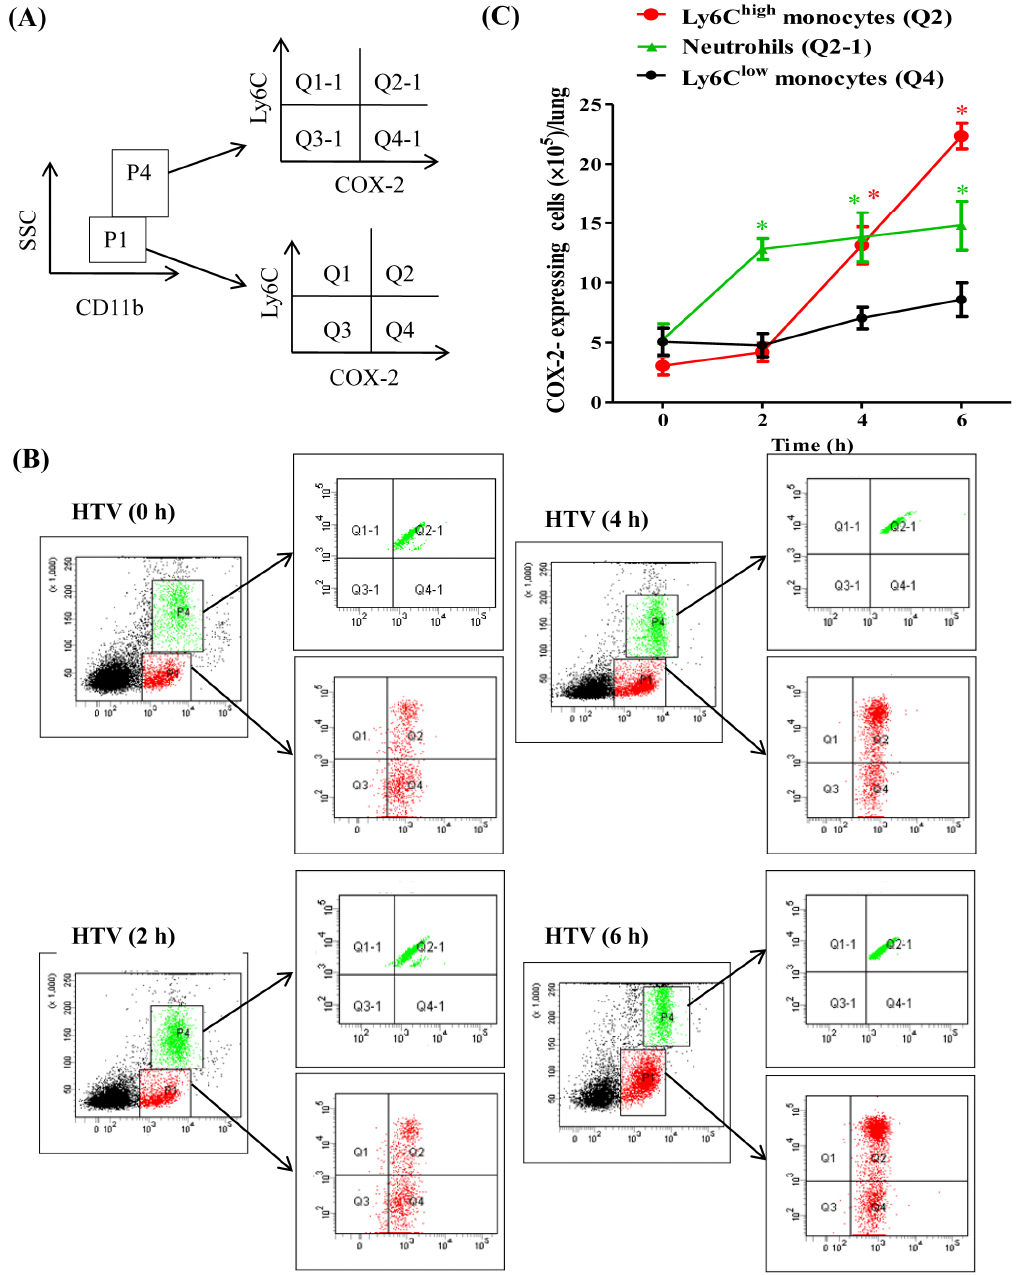
Figure 2. Cyclooxygenase-2 (COX-2)-expressing Ly6C high monocytes recruited into the lung during VILI. ( A , B ) Gating strategy of flow cytometry analysis. ( C ) Time course recruitment of COX-2-expressing Ly6C high monocytes, Ly6C low monocytes, and neutrophils during VILI. Values represent the mean ± SD ( n = 6). * p < 0.01 as compared with the control at that time point. 2.3. Celecoxib Aignificantly Mitigates the Recruitment of Ly6C high , but Not Ly6C low , Monocytes in VILI